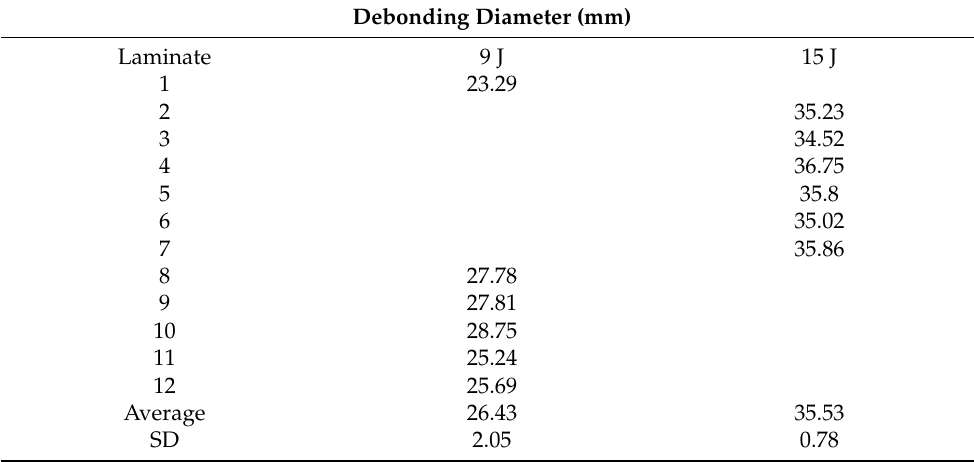
Figure 14. A-scan, B-scans, and C-scan of 3R laminate after 9 J ( left ) and 15 J ( right ) low-velocity impact (A is the area, C is the circle length and D is the diameter of the circle). Table 3. Delamination diameters of the impacted 3R laminates.